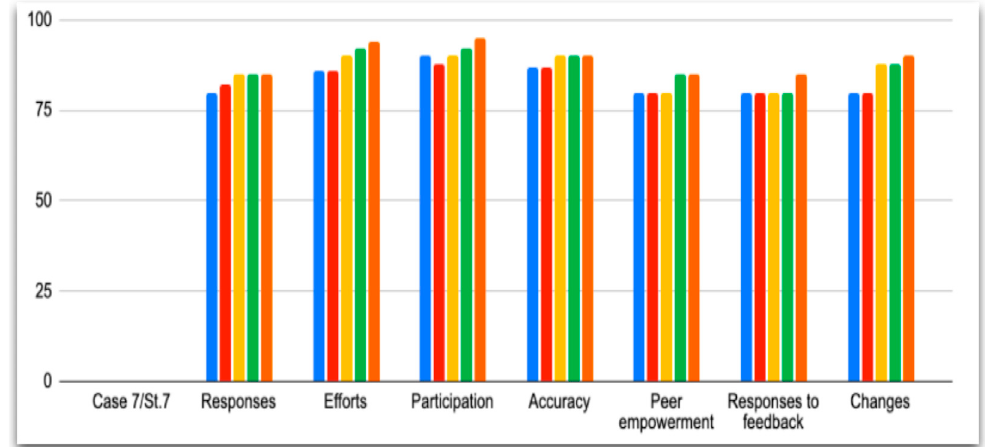
Figure 7. Vocabulary and spelling progress during alternative assessment online/Case 7.